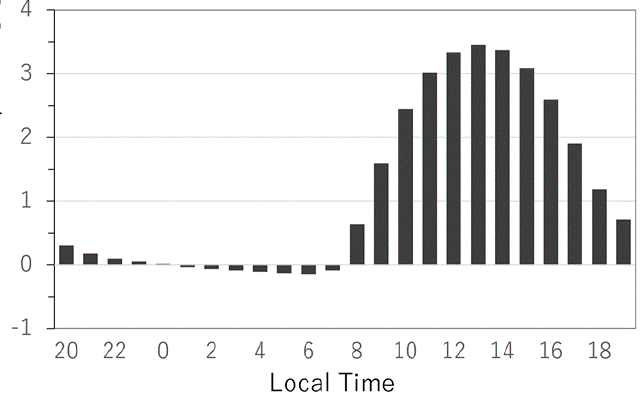
Figure 7. Differences in area-averaged potential temperatures at 100 m above the surface between land and sea over the region indicated in Figure 6.